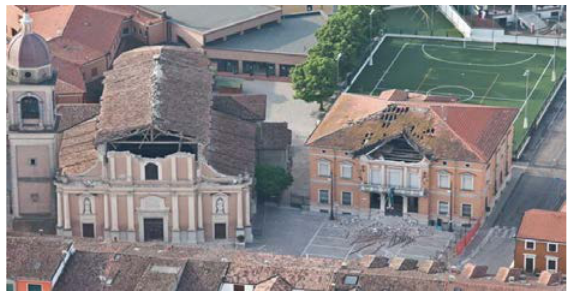
Figure 1. The church of Moglia (near Mantua) and the Municipality seriously damaged after the earthquake.